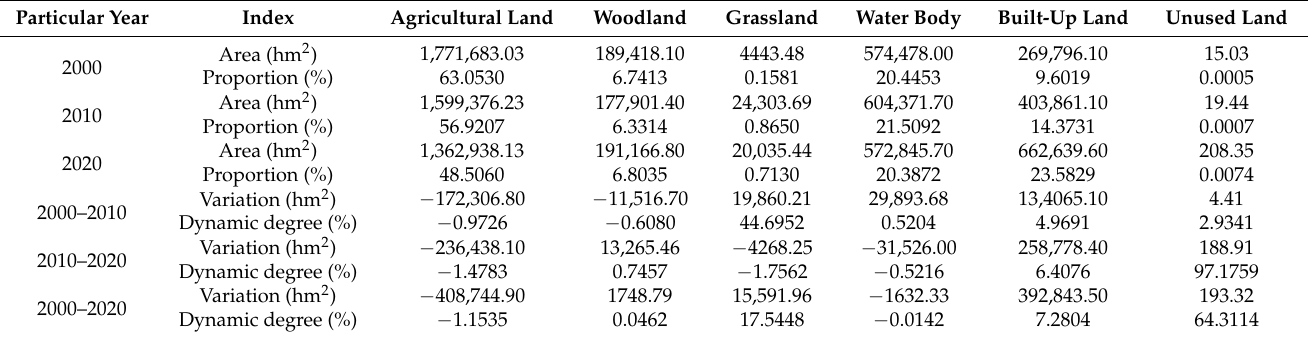
Table 2. Land-use area in southern Jiangsu from 2000 to 2020 [Unit: hm 2 ] and its proportion [Unit: